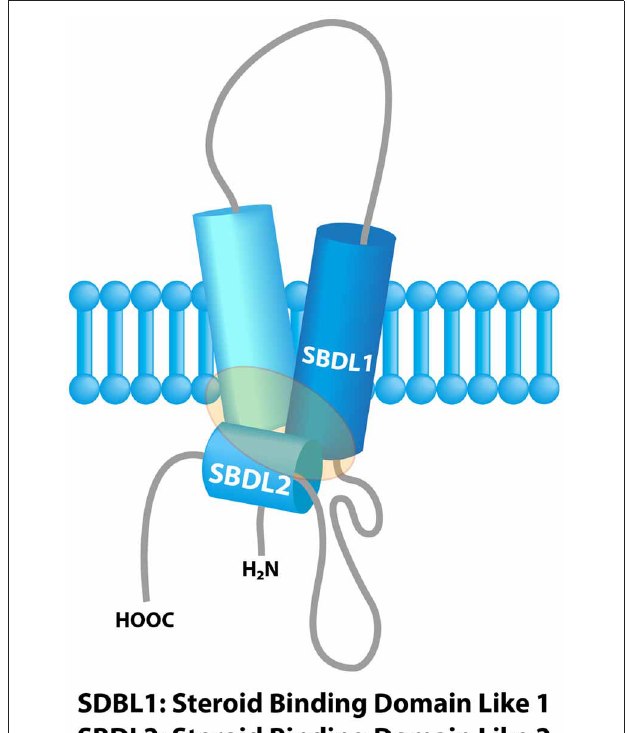
FIGURE 1 | Model of the sigma-1 receptor binding region from previous photolabeling studies. The shaded area represents the ligand binding region. Adapted with permission from Chu et al.